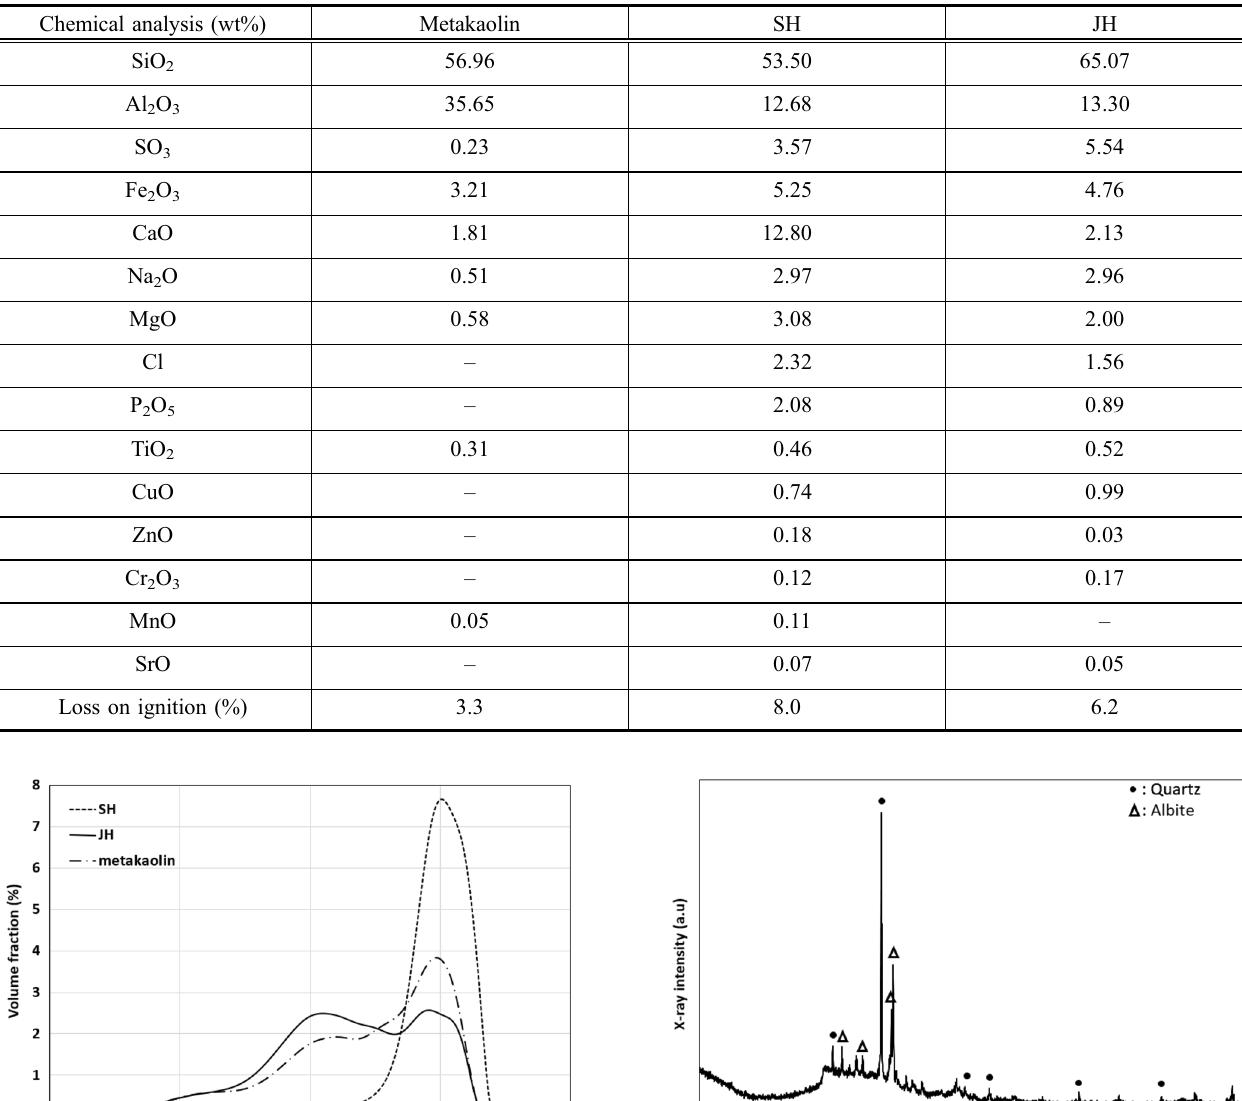
Table 3 Chemical composition of dredged sea soil and metakaolin.